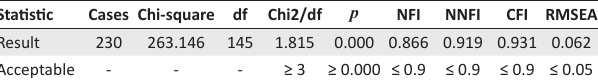
The major diagonal and bold figures show the square root of average variance extracted (AVE). RMSEA, root mean square error of approximation; CFI, comparative fit index; AVE, average variance extracted; NFI, normed fit index; PRG, perceived raltional governance. TABLE 5: The goodness-of-fit indices. Statistic